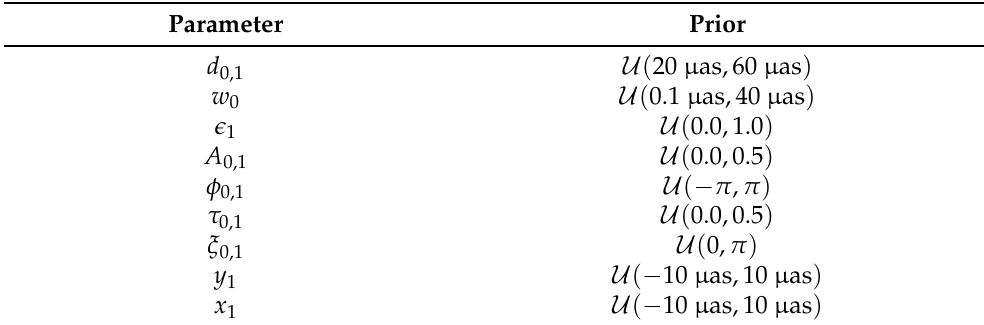
Table 2. Priors used for the geometric self-fits with two m-ring components. U ( a , b ) represents the uniform distribution on the interval ( a , b )